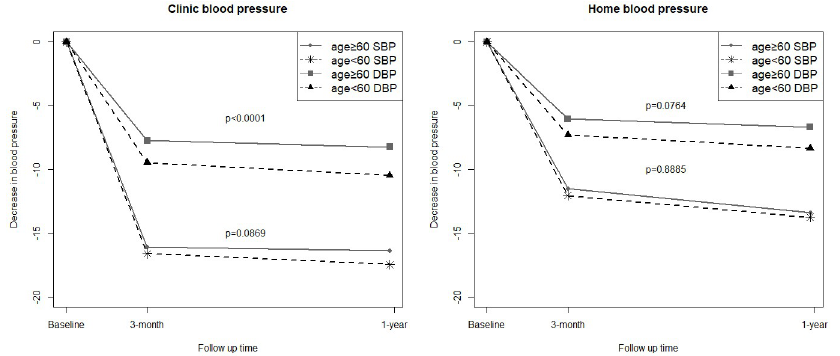
Fig 1. BP reduction over time during the 1 year of fimasartan treatment in elderly vs. nonelderly patients. Elderly patients exhibited a lesser and more gradual decline in clinic DBP than nonelderly patients during the 1 year of fimasartan treatment (left panel). Elderly patients also exhibited a lesser and more gradual decline in home DBP than nonelderly patients during the 1 year of fimasartan treatment, also the difference was not statistically significant (right panel). P value was obtained by repeated measures analysis of variance. Abbreviations: BP, blood pressure; DBP, diastolic BP; SBP, systolic BP.